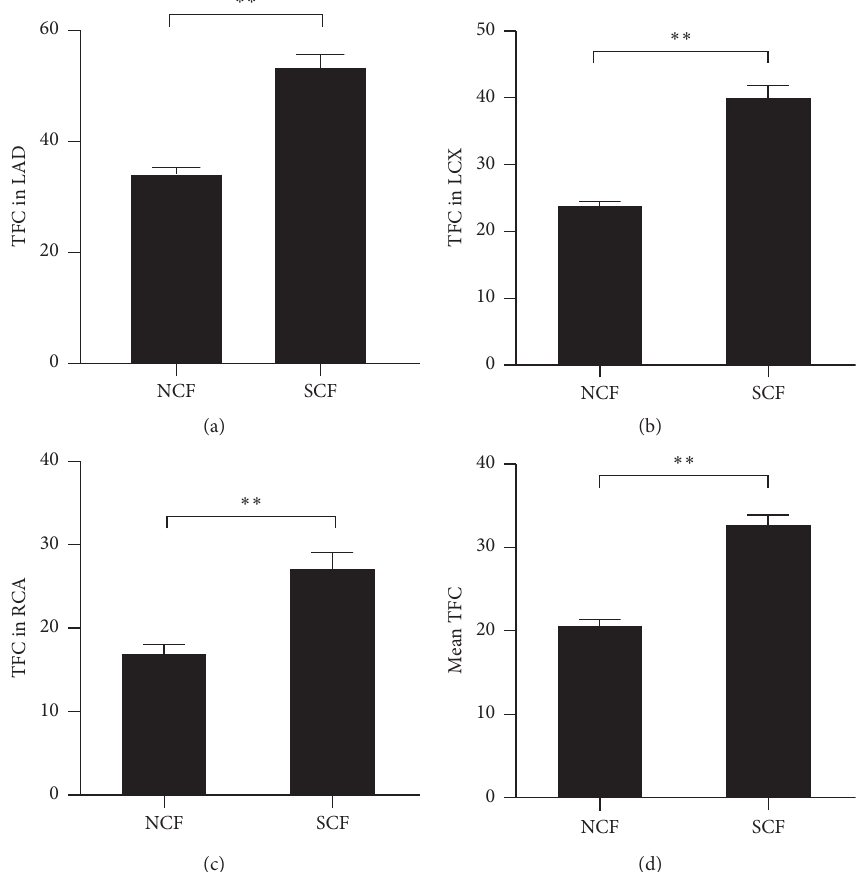
Figure 1: Thrombolysis in Myocardial Infarction (TIMI) frame count (TFC) in patients with NCF and SCF. (a) TFC in LAD between patients with NCF and SCF. (b) TFC in LCX between patients with NCF and SCF. (c) TFC in RCA between patients with NCF and SCF. (d) Mean TFC of LAD, LCX, and RCA between patients with NCF and SCF. LAD, left anterior descending; LCX, left circumflex; and RCA, right coronary artery. Data were expressed as mean ± SEM. ∗∗ P < 0 . 01.